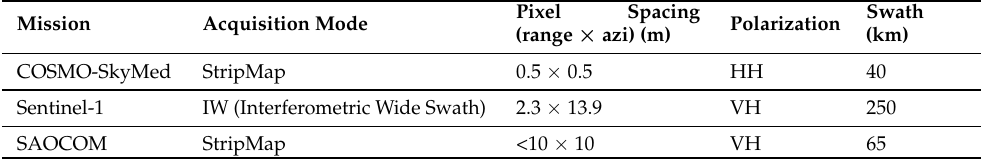
Table 1. MM/MF product specifications in terms of acquisition mode, pixel spacing, and polarization.